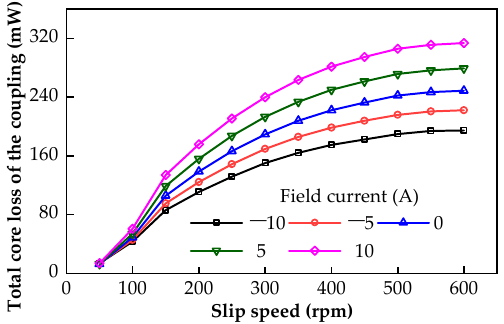
Figure 11. The core losses under different field currents.